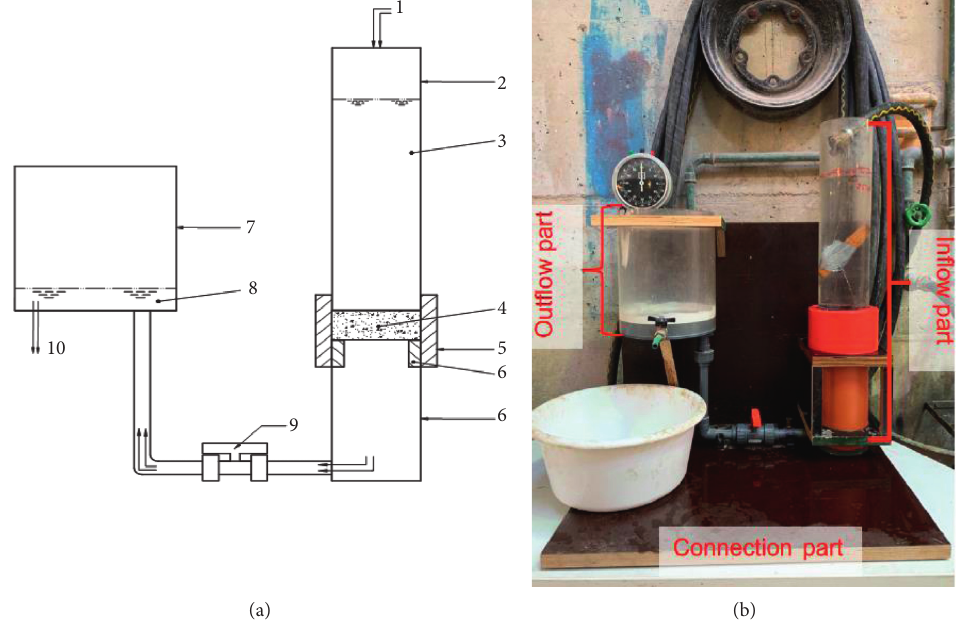
Figure 4: Apparatus for permeability test. (a) Schematic diagram of apparatus (1: water inlet; 2: graduated plastic cylinder; 3: influent water head; 4: specimen; 5: upper rubber sleeve; 6: lower rubber sleeve; 7: outflow tube; 8: effluent water head; 9: water shut-off valve; and 10: water outflow). (b) Physical map of